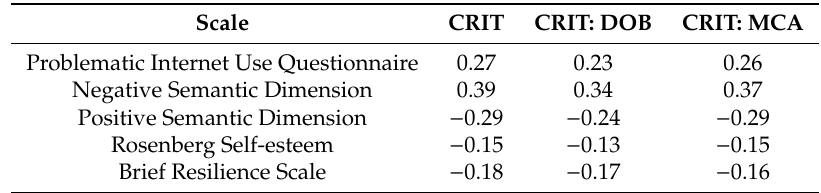
Table 4. Correlations between CRIT and its latent factor structure in relation to other construct-related